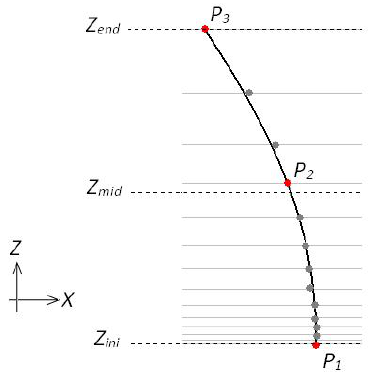
Figure 12. Method for converting the projected fragment into a